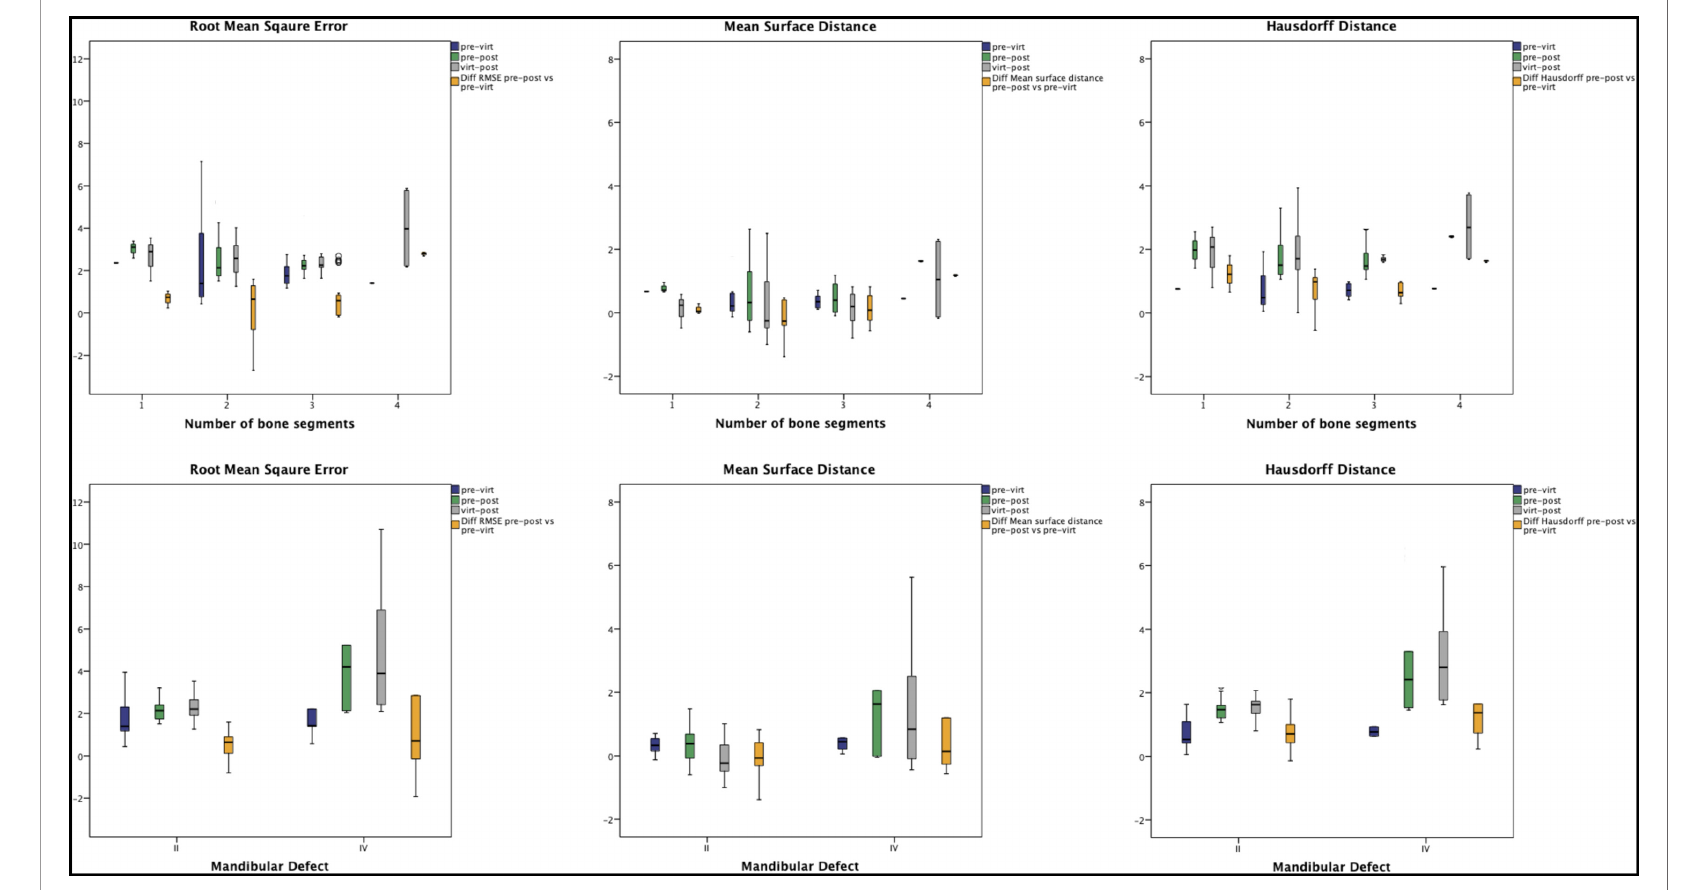
FIGURE 4 | The results for the RMSE, MSD, and HD analyses as a function of number of bone segments (upper row) or mandibular defect class (lower